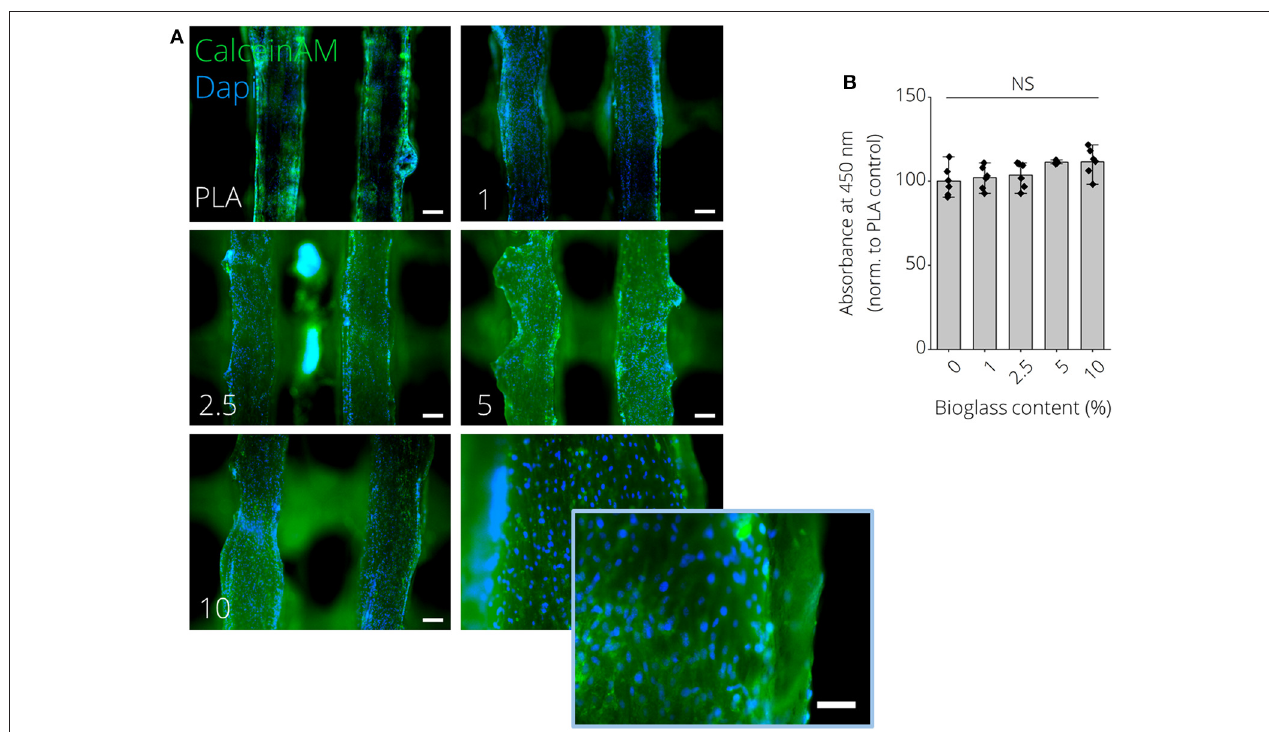
FIGURE 7 | MC3T3E1 pre-osteoblast cells cultured on 3D printed PLA-BG substrates for 24h. (A) Fluorescence microscopy images of Calcein AM (green)/DAPI (blue) stained MC3T3E1 on 3D printed PLA-BG scaffolds with 0, 1, 2.5, 5, and 10% BG, respectively. Scale bars: 200 µ m, 100 µ m (insert, bottom right). (B) Indirect